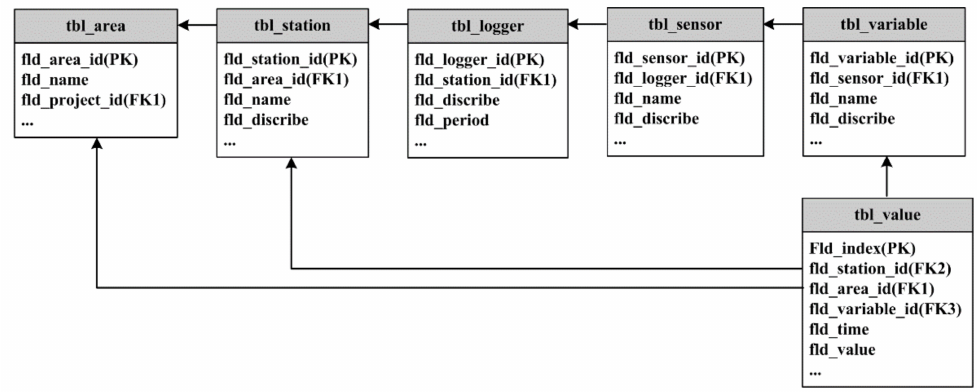
Figure 4. Conceptual structure of the relational observational database in the IODCS.